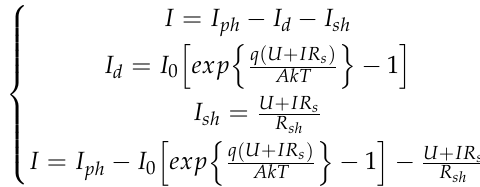
Figure 7. Irradiance and PV power generation changing curve over time.